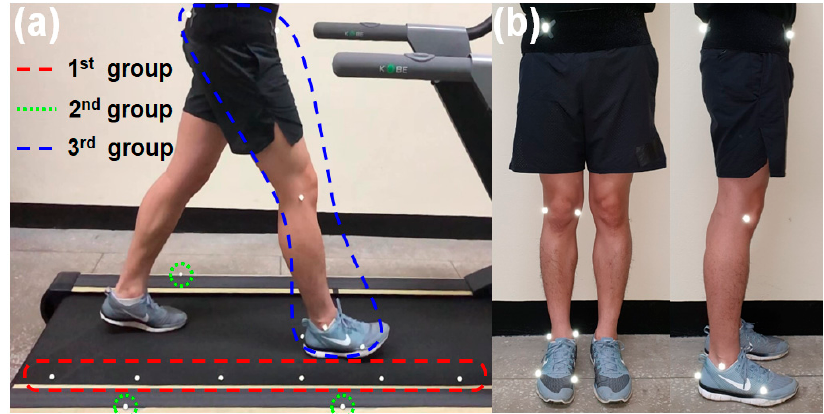
Figure 2. ( a ) Walking test setup with markers attached to a treadmill and a subject; ( b ) subject- attached markers viewed from the coronal and sagittal planes.